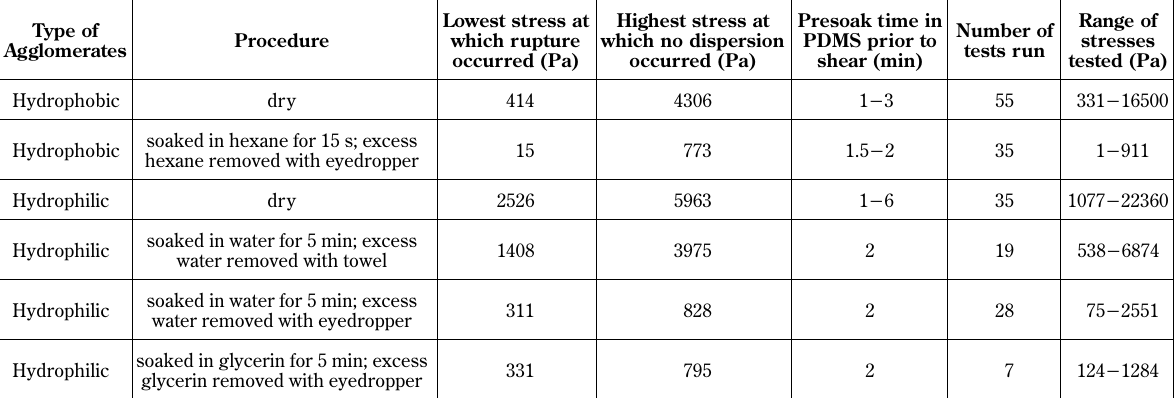
Type of Lowest stress